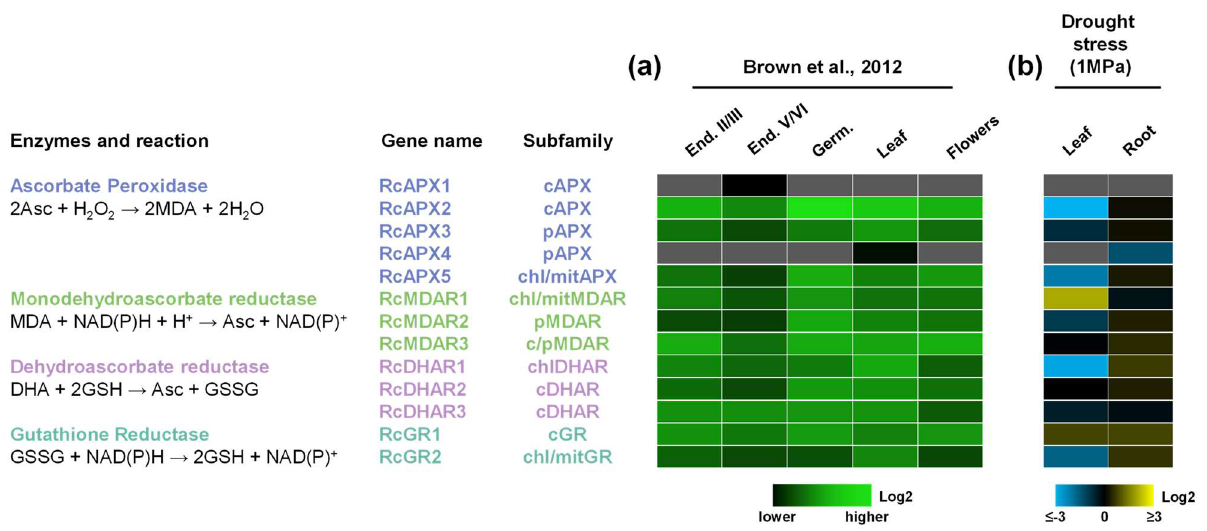
Figure 5. Expression profile of APX, MDAR, DHAR, and GR genes in castor bean. ( a ) Heatmap showing the expression pattern of AsA-GSH cycle genes in seeds during different developmental stages, such as endosperm II-III (End. II-III), endosperm V-VI (End. V-VI), and Germinating (Germ.), in leaves and male flowers from castor bean. The color scale represents log2 expression values, expressed in a green color scale. ( b ) Heatmap showing the expression pattern of AsA-GSH cycle genes in leaf and root in response to drought stress. The color scale represents log2 expression values, expressed in a blue to yellow color scale, relative to the expression values under control conditions.